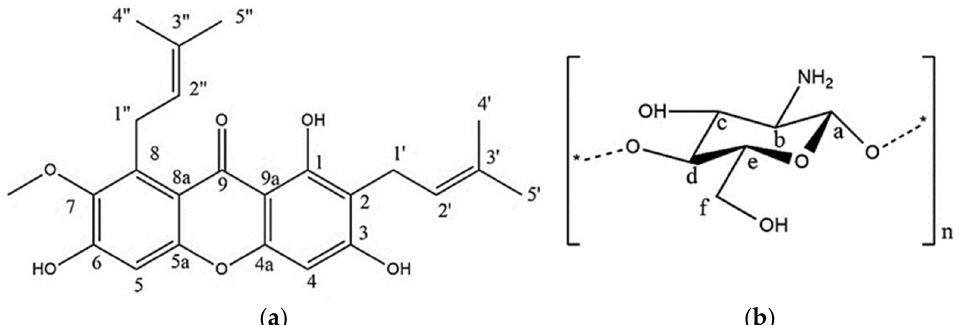
Figure 1. Chemical structures of ( a ) alpha-mangostin (AM) and ( b ) water-soluble chitosan (WSC).